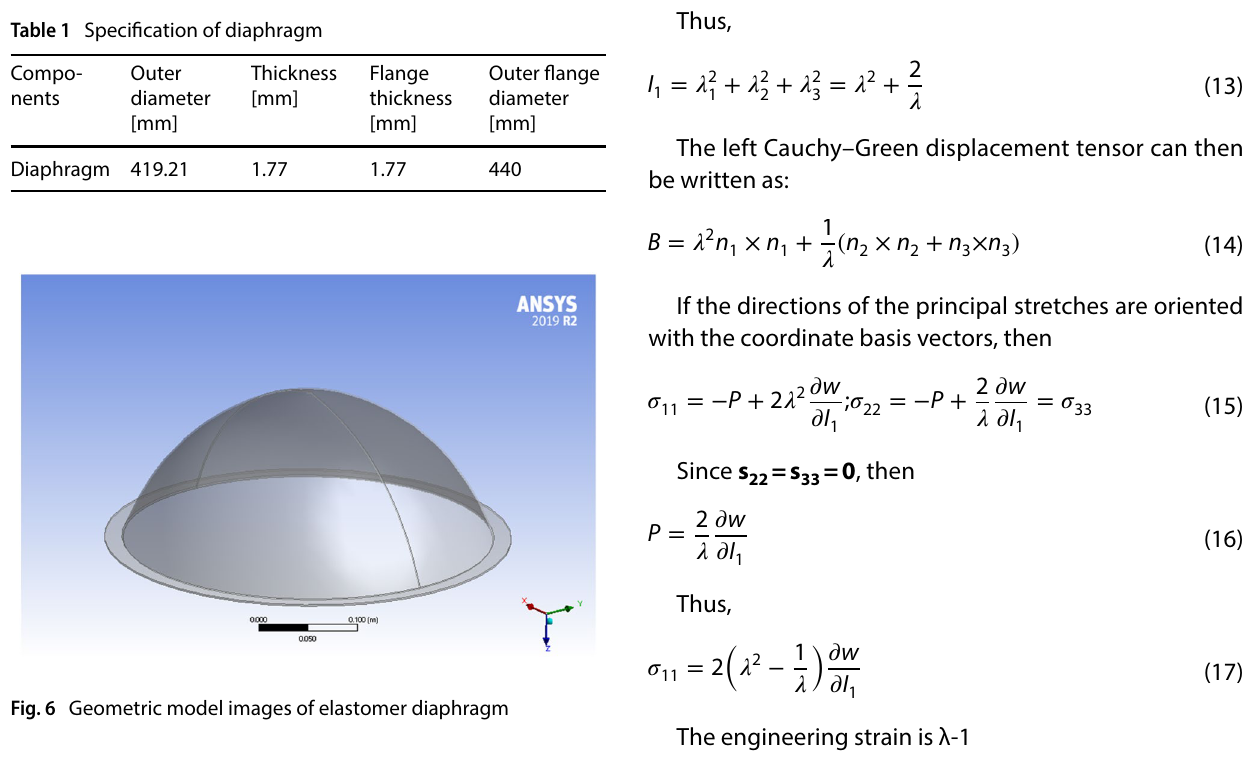
Fig. 5 Solid Works model of the sample diaphragm tank